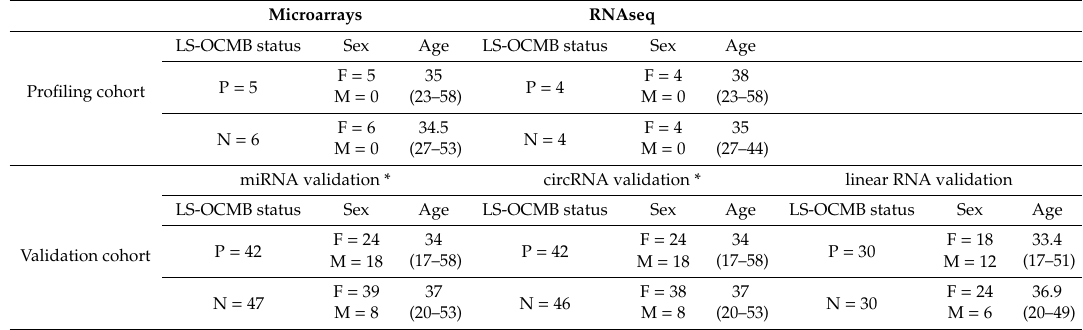
Table 1. Summary of patients’ clinical and demographical